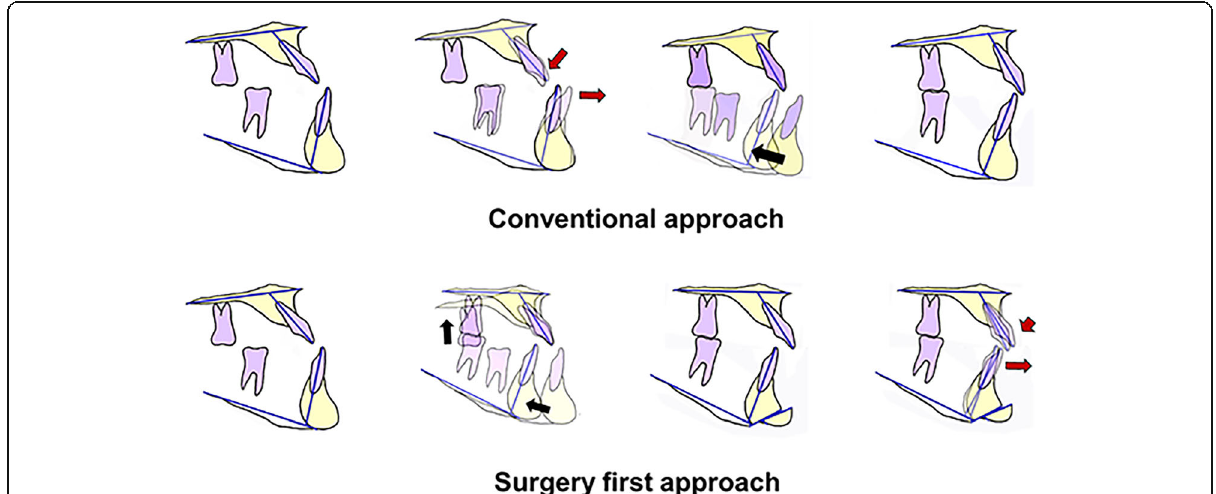
Fig. 2 Overall concept of the SFA compared to the conventional approach. Instead of dental decompensation using the orthodontic treatment before surgery, SFA utilizes more surgical approaches for dental decompensations (red arrow, orthodontic treatment; black arrow, surgical movements)